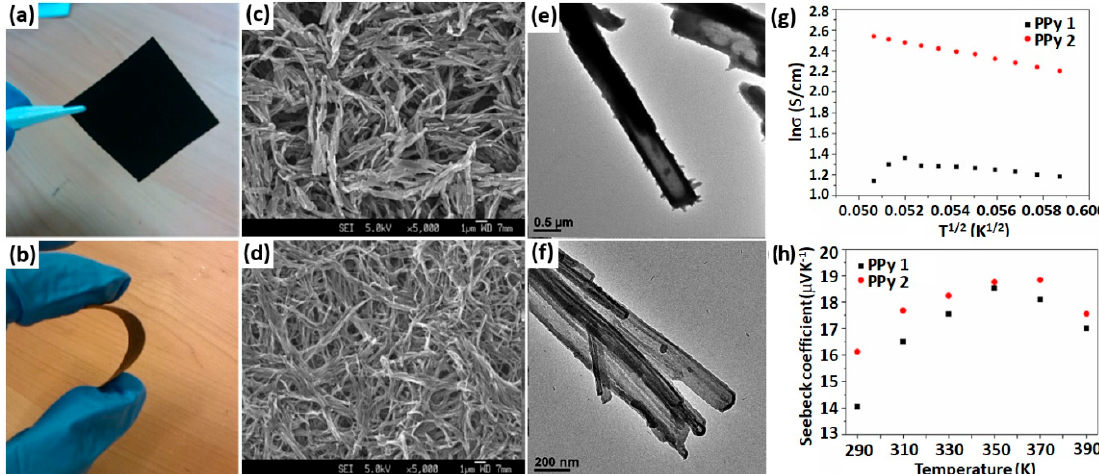
Figure 6. ( a , b ) Photographs of the flexible free-standing PPy nanotube film. SEM images of the free-standing ( c ) PPy-1 films and ( d ) Ppy-2 films. TEM images of ( e ) PPy-1 nanotubes and ( f ) PPy-2 nanotubes. The temperature dependence of ( g ) electrical conductivity and ( h ) Seebeck coefficient of PPy-1 and PPy-2 films. Readapted with permission from Elsevier B.V. [71].